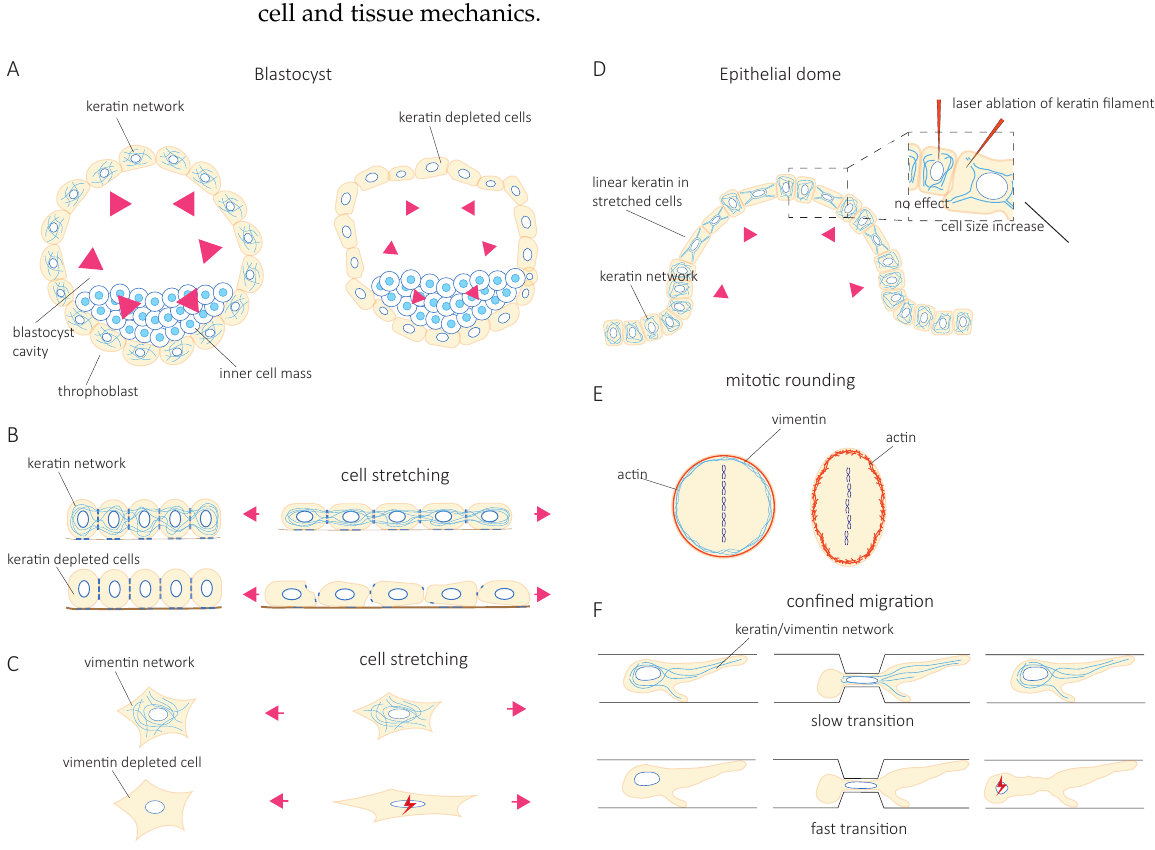
Figure 1. Intermediate filaments, guardians of tissue and cell integrity, adapt cell mechanics to cell behavior. ( A ). During embryo cavitation, keratins are essential to generate apical tension (pink arrowheads) against the increasing internal pressure in the blastocyst. This tension is lost in the absence of keratin 8 and 18, which leads to a decrease in volume and increased surface curvature. ( B , C ). Depletion of keratin in a collective cell sheet and vimentin in single cells increases cell deformation upon stretching. In vimentin-depleted cells, this leads to an increase in cell death. ( D ). Expanded